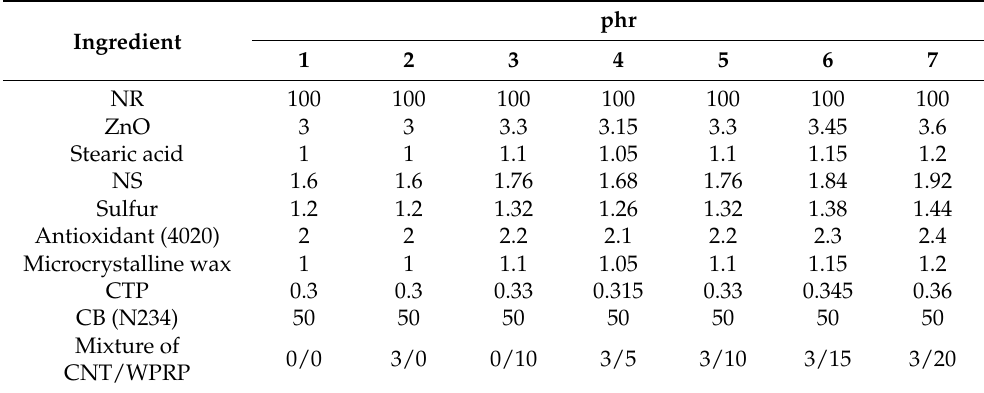
Table 1. The formulas of the CNT/WPRP/NR